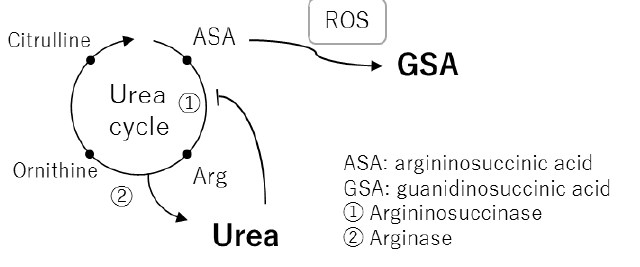
Figure 6. A metabolic pathway map of the urea cycle and related metabolites as a basis for correlation between blood urea nitrogen (BUN) and guanidinosuccinic acid.